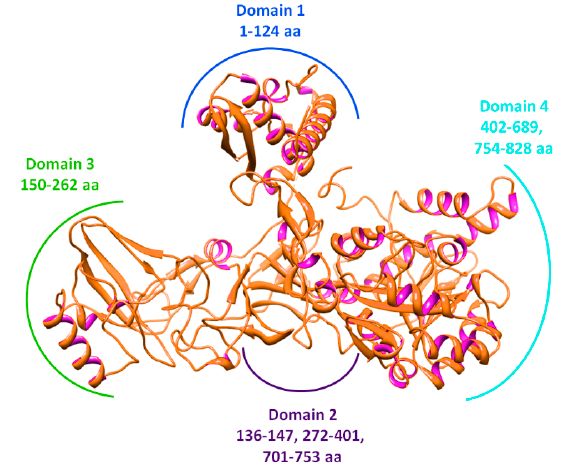
Figure 5. Crystal structure of jack bean urease.